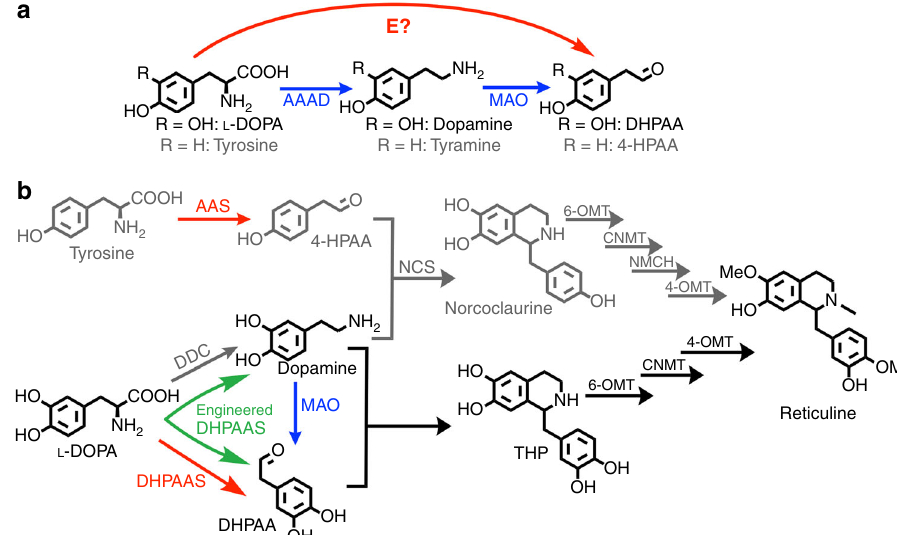
Fig. 1 Design of a symmetrical THP pathway for reticuline bioproduction. a M-path enzyme (E) search identi fi ed phenylacetaldehyde synthase (PAAS), 4- HPAA Synthase (4-HPAAS), and DHPAAS as putative enzymes to directly produce 4-hydroxyphenylacetaldehyde (4-HPAA) from tyrosine or DHPAA from L -DOPA (Supplementary Table 1). b Multiple pathways lead to THP and norcoclaurine production, including a nonsymmetrical DDC-MAO-mediated pathway (blue and grey arrows), symmetrical DDC-DHPAAS/AAS-mediated pathways (red and grey arrows), and an engineered DHPAAS single enzyme system (green split arrows). ( S )-norcoclaurine can be produced from 4-hydroxyphenylacetaldehyde (4-HPAA) and dopamine via the enzyme ( S )- norcoclaurine synthase (NCS, EC 4.2.1.78). Dopamine and DHPAA undergo spontaneous Pictet-Spengler condensation to form THP (3-hydroxy- norcoclaurine), or this reaction can also be catalyzed by NCS. THP is converted to reticuline via norcoclaurine 6- O -methyltransferase (6-OMT),